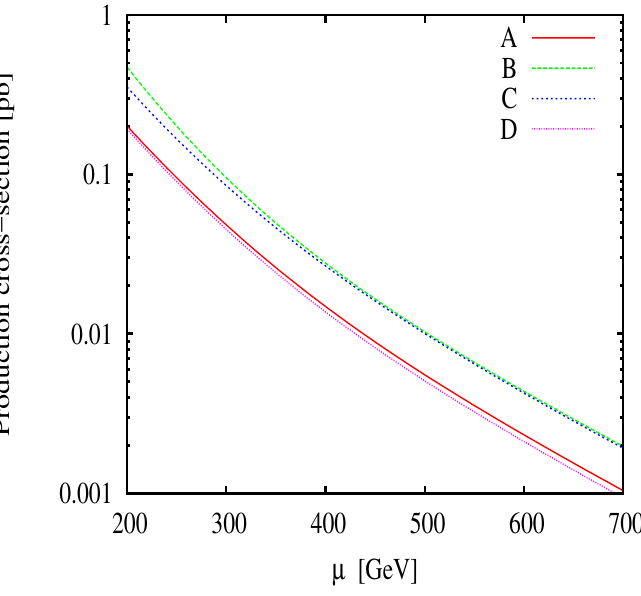
p s = 13 TeV. Here, A =